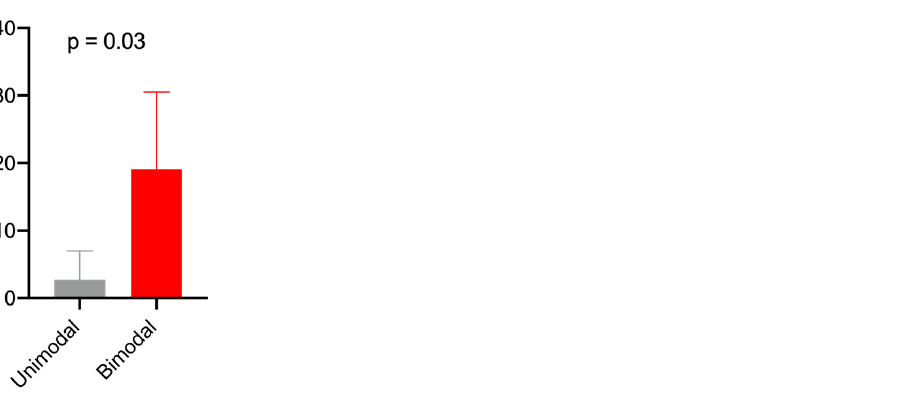
Figure 4. Differential expression of AKT3 mRNA in unimodal and bimodal EOC cell lines.